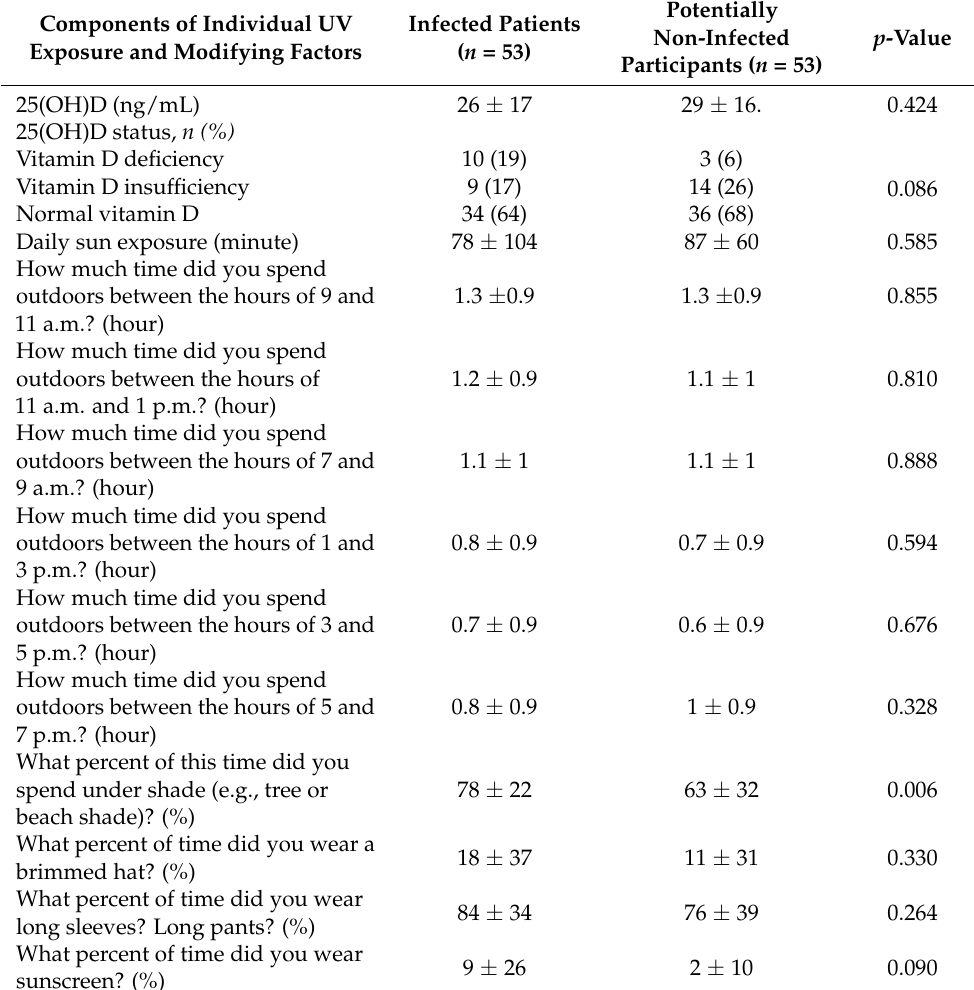
Table 2. Vitamin D status and characteristic items were used to measure individual sunlight exposure among patients infected with SARS-CoV-2 and potentially non-infected participants 1